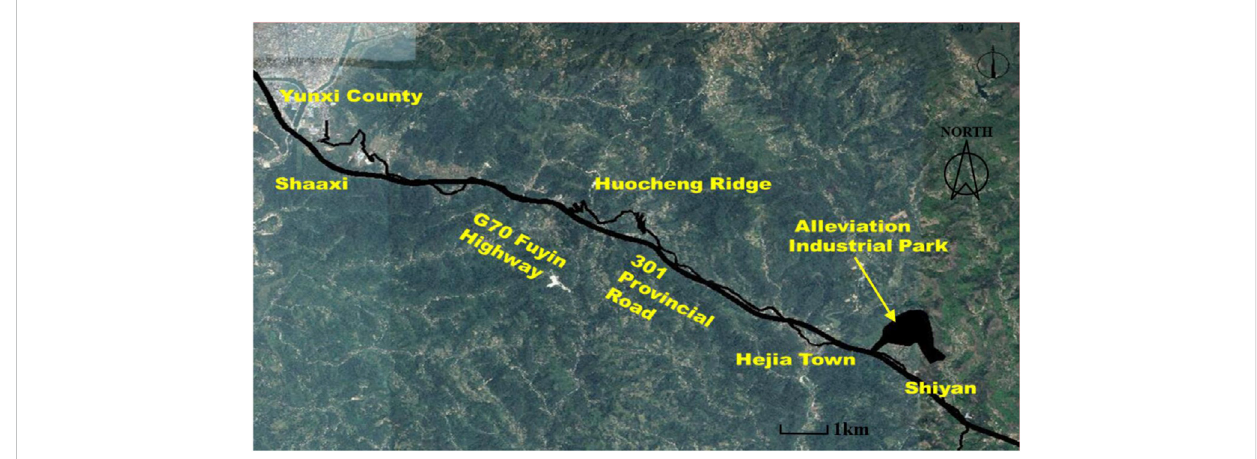
FIGURE 1 Location of the alleviation industrial park.